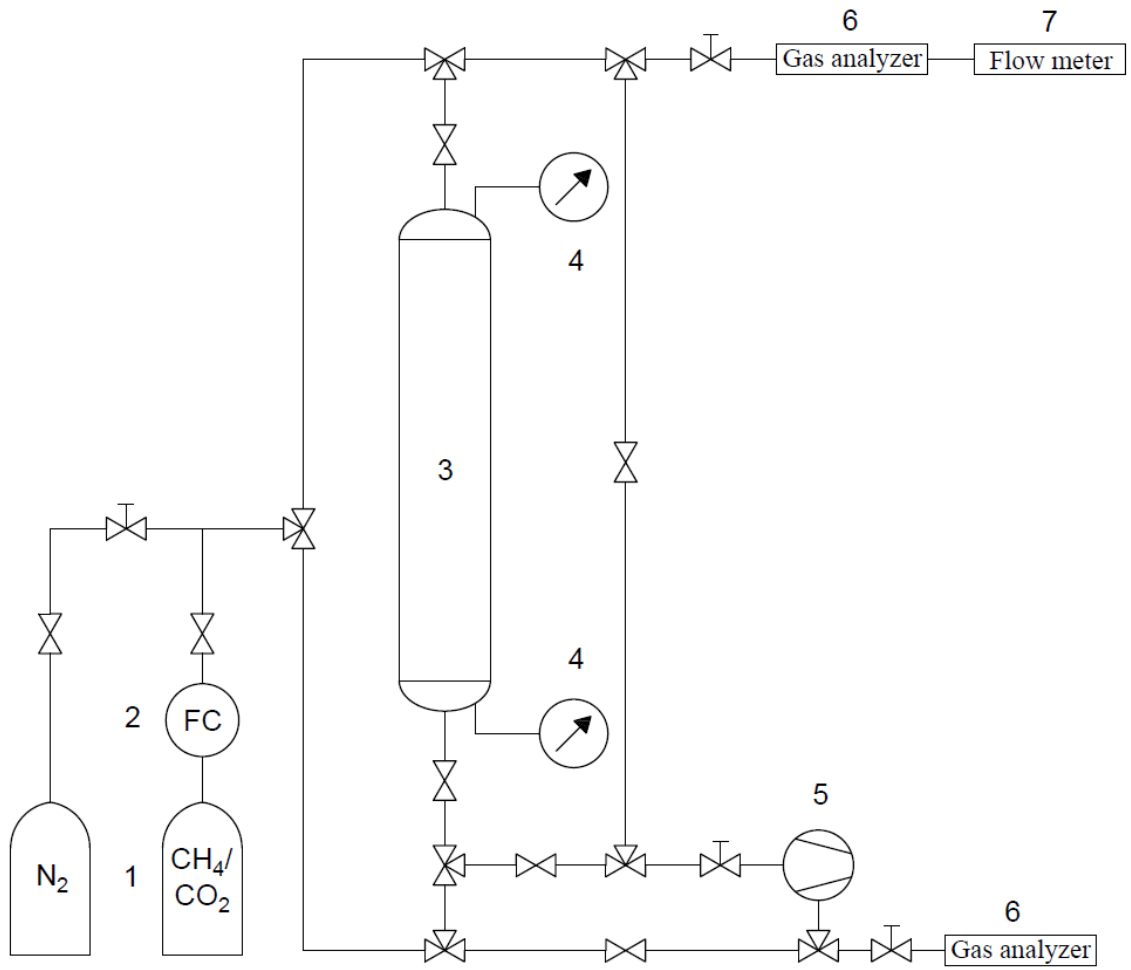
Figure 3. Scheme of the breakthrough apparatus: 1—gas bottles; 2—mass flow controller; 3 adsorption column; 4—pressure sensors; 5—vacuum pump; 6—gas analyzers; 7—flow meter.